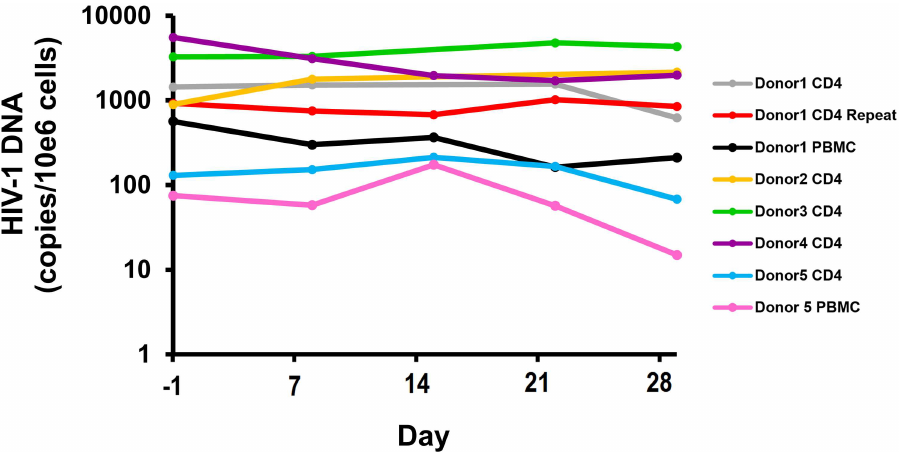
Fig 4. Levels of HIV DNA during cell culture. The frequency of HIV-infectedcells was quantified using